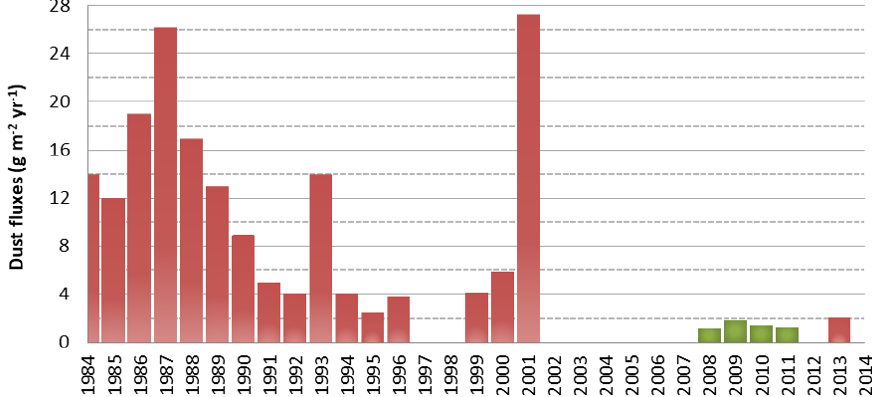
Figure 3. Time series of dust fluxes (gm − 2 yr − 1 ) at various locations in Corsica issued from Löye-Pilot and Martin (1996) for years between 1984 and 1994, from Ridame et al. (1999) for 1995 and 1996, from Guieu et al. (2010) for 2001–2002, from Vincent et al. (2016) for 2013 (all in red), and from this work for 2008–2011 (in